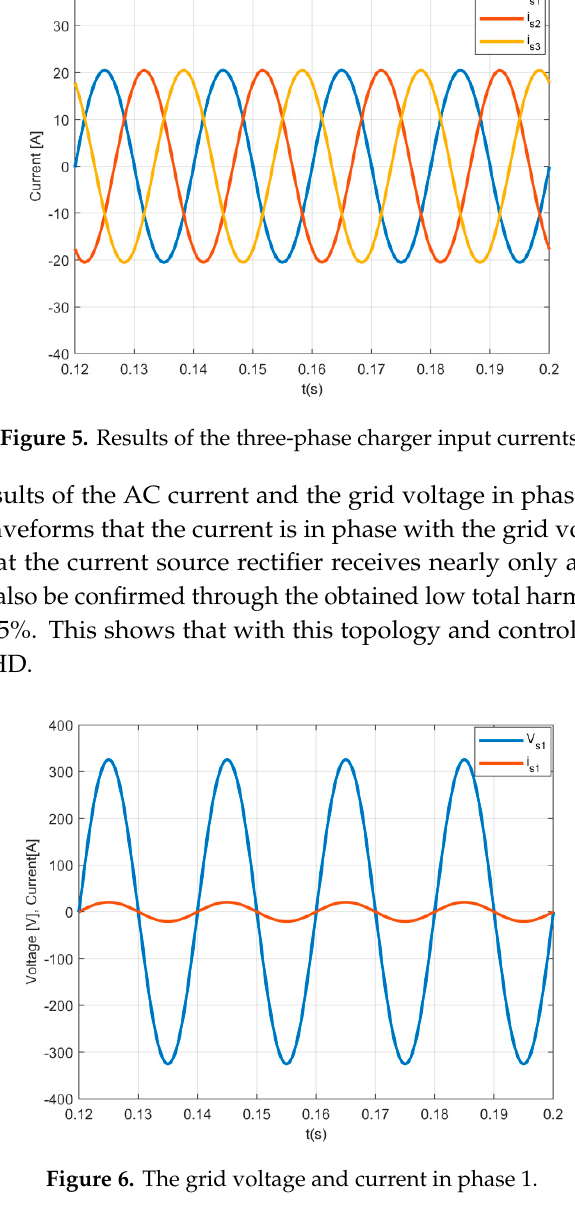
Figure 7. The motor winding current (i A ).